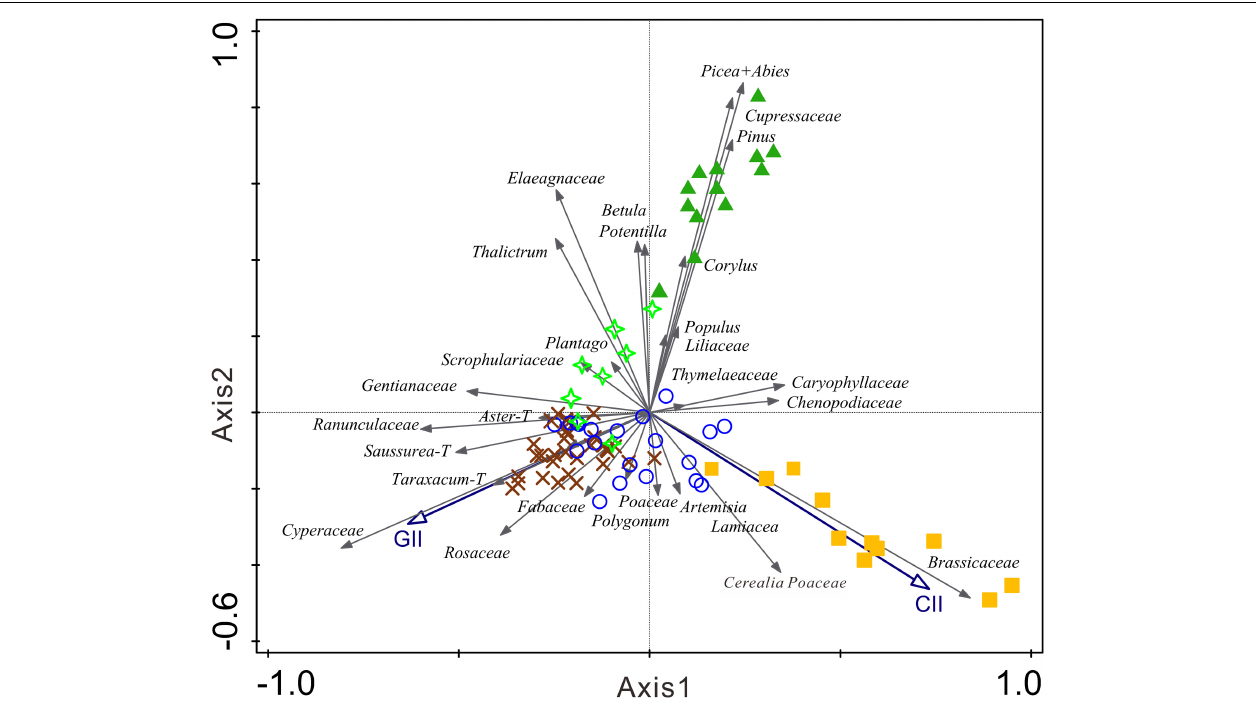
FIGURE 3 | Principal component analysis (PCA) results for pollen assemblages of topsoil samples, CII and GII are included as supplementary variables. Green triangles are samples from mountain forest, green stars are samples from alpine shrub, yellow squares are samples from croplands, brown crosses are samples from alpine meadow, and blue circles are samples from alpine